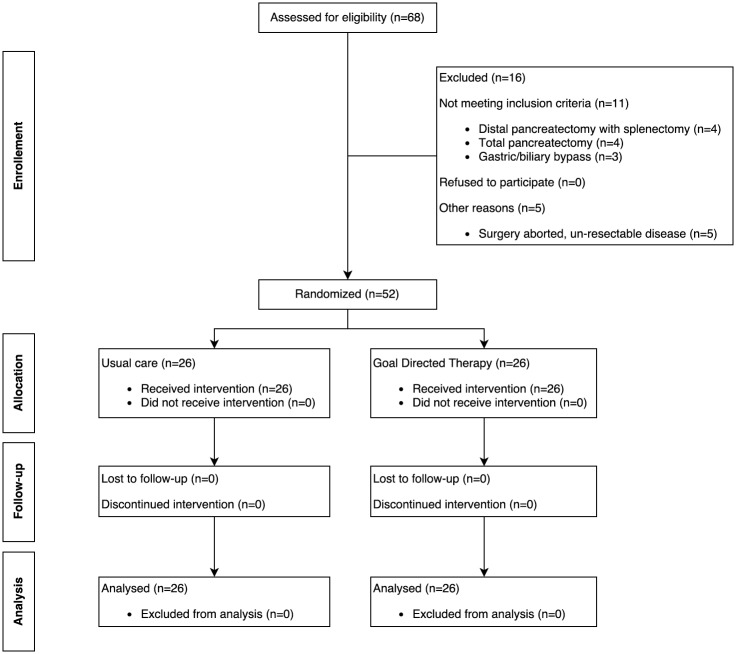
Consort diagram.